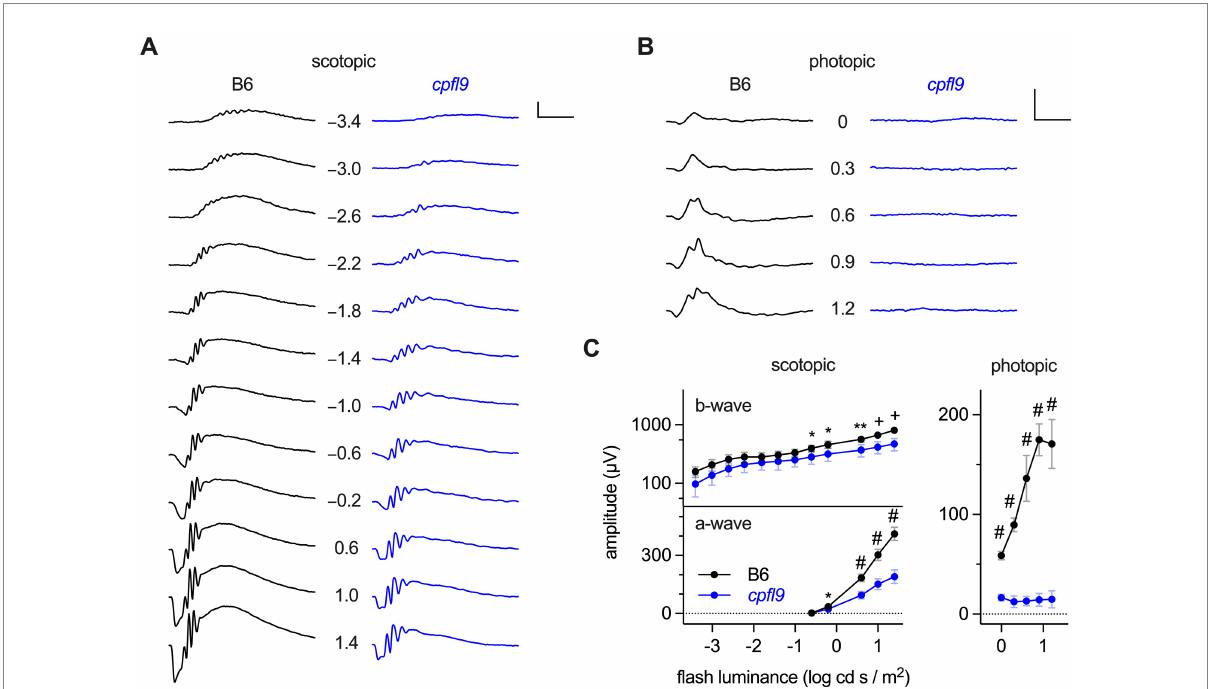
FIGURE 1 ERG responses of B6 and homozygous cpfl9 mice at four weeks of age. (A) Representative scotopic ERG responses to light stimuli of increasing intensity as measured in a single eye of B6 (black traces) and homozygous cpfl9 (blue traces) mice. Traces show the mean response recorded from two flashes. The flash illuminance in log cd s/m 2 is indicated. (B) Photopic responses of the same eyes. Vertical scale bars in A and B , 200 μ V; horizontal, 50 ms. (C) Light dose–response analysis showing scotopic b-wave and a-wave and photopic b-wave amplitudes of B6 (black circles, n = 7) and cpfl9 (blue circles, n = 8). Values indicate mean ± SD. Two-way repeated-measures ANOVA indicated a statistically significant effect of strain on each response (scotopic b-wave, F (1, 13) = 16.5, p = 0.0013; scotopic a-wave, F (1, 13) = 131.6, p < 0.0001; photopic b-wave, F (1, 13) =